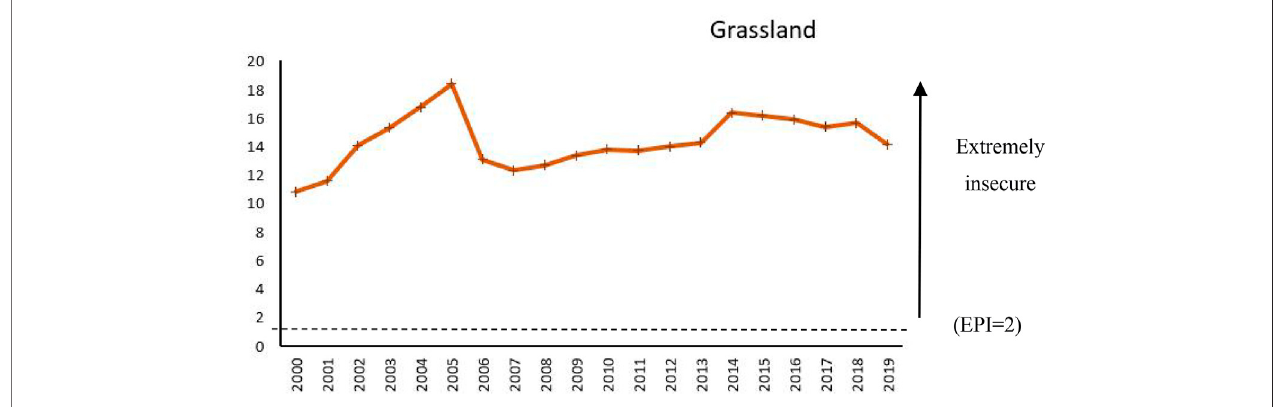
FIGURE 10 | Trend map of grassland EPI extremely insecure.